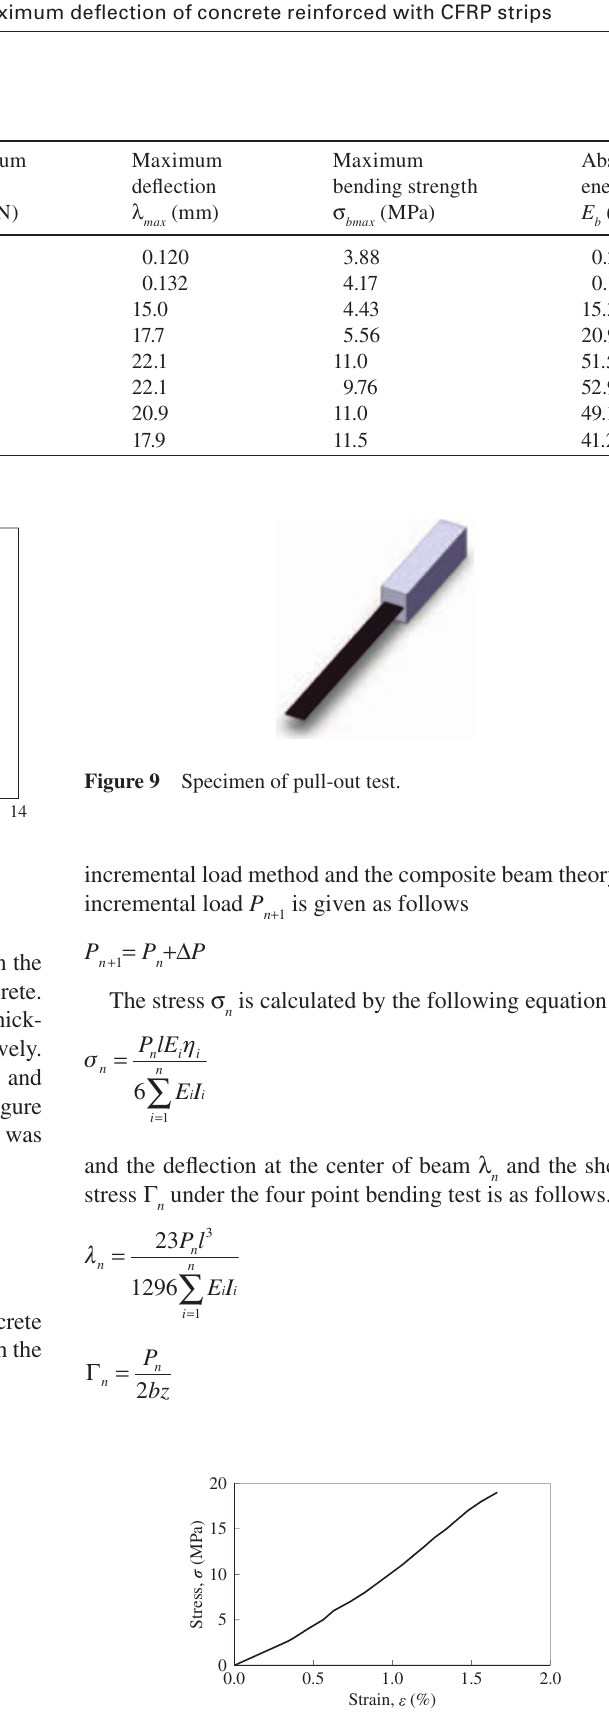
Figure 10 Stress-strain curves in pull-out